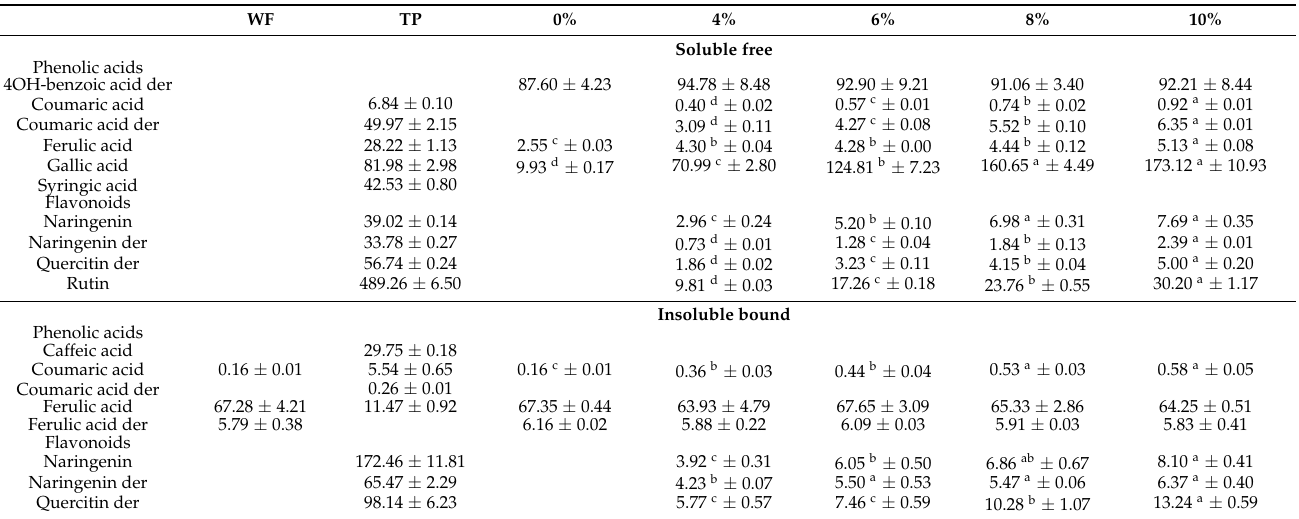
Table 5. Phenolics content (mean ± standard deviation) of wheat flour (WF), tomato pomace (TP), and cream crackers with increasing TP percentages. Different letters indicate significant differences ( p ≤ 0.05) among cream crackers along a